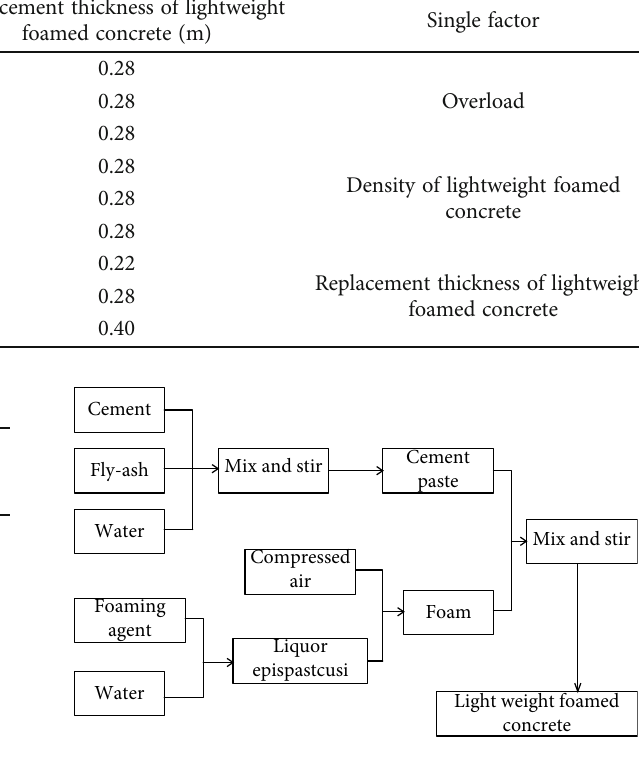
Figure 7: Preparation process of lightweight foamed